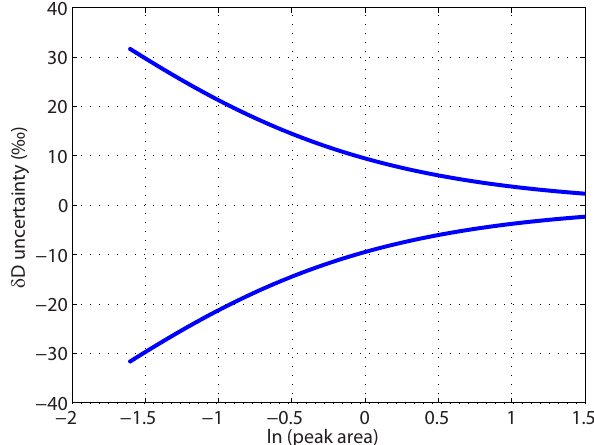
Figure 4. Calculated total assigned uncertainty of δ D (consisting of analytical uncertainty and uncertainty arising from the linearity correction) for air samples with ln(peak area) ranging from − 1.6 to